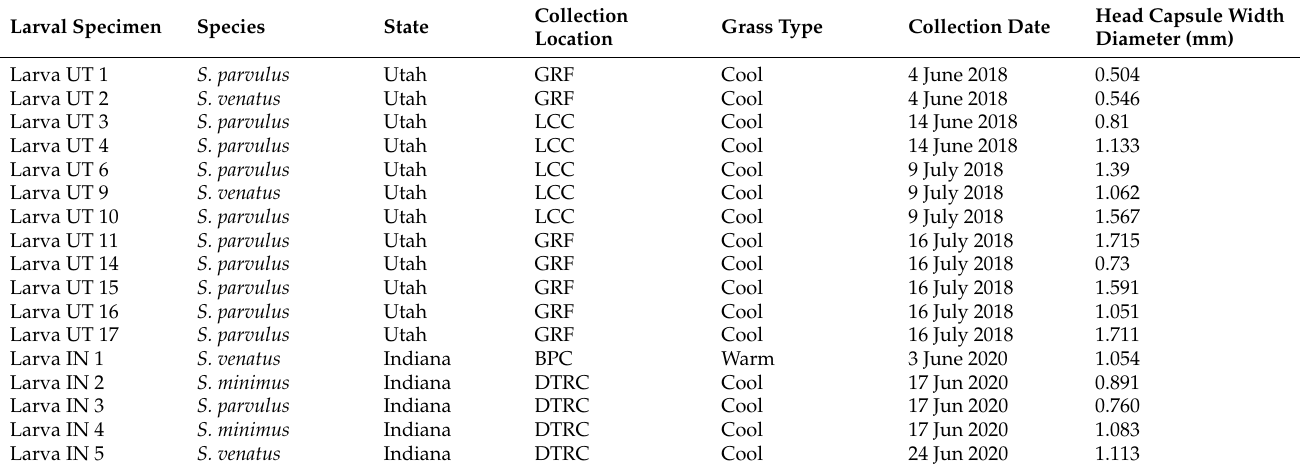
Table A1. Association of each larval specimen with its respective species identification ( Shenophorus parvulus , S. venatus , and S. minimus ), state (Utah and Indiana), collection location (DTRC = William H. Daniel Turfgrass Research and Diagnostic Center, GRF = Greenville Research Farm, LCC = Logan Country Club, BPC = Bimmel Practice Complex), grass type (Cool-season=Poa pratensis, warm-season= Cynodon dactylon ‘Patriot’ and Zoyzia japonica ‘Meyer’), collection date, and head capsule width diameter